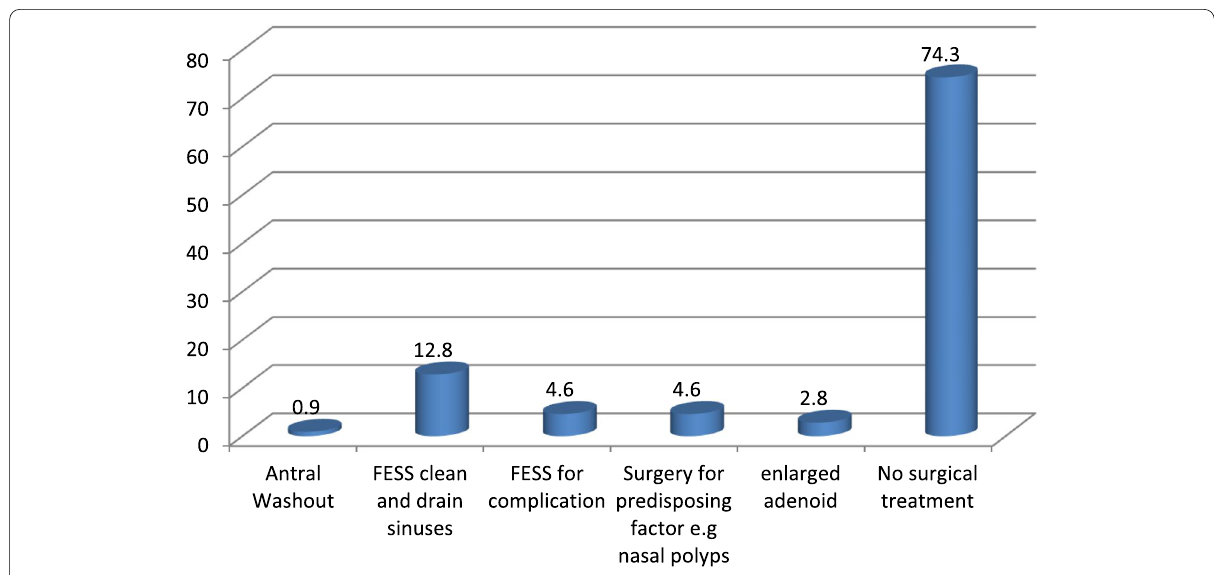
Fig. 3 Distribution of surgical treatment of patients with acute